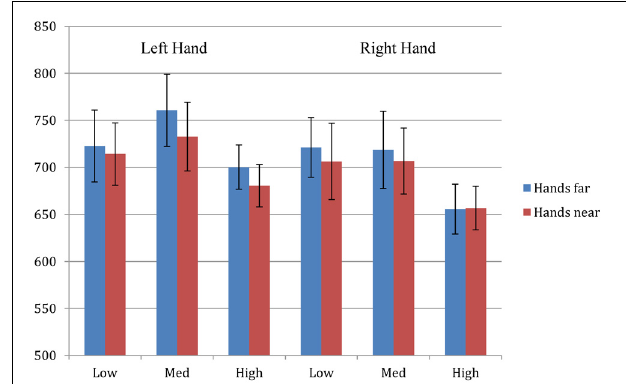
FIGURE 4 | Experiment 3 results. ANOVA revealed a significant main effect of laterality ( F = 10.134, p = 0 . 005) and pitch ( F = 4.201, p = 0 . 022), but not hand proximity ( F = 1.357, p = 0 . 258) or other interaction terms. Separate comparisons under laterality revealed that, like Experiment 1, participants’ right hand responses were significantly faster than their left hand responses ( p = 0 . 005). Separate comparisons under pitch also revealed that, like Experiment 2, participants’ responses toward the high tone were significantly faster than those toward the low ( p = 0 . 051) and med tones ( p = 0 . 018). Thus, all the general effects from Experiments 1 and 2 are replicated, except the effect of hand